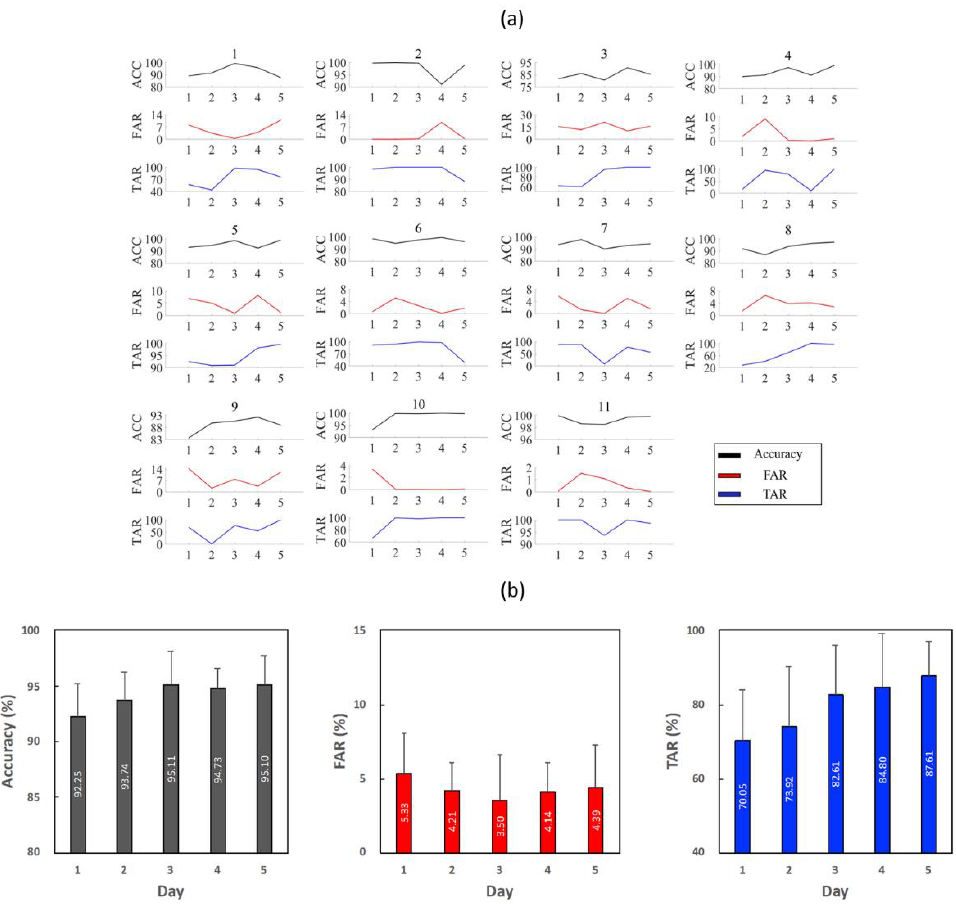
Figure 12. The accuracy, FAR and TAR of 11 subjects over five days of incremental learning ( a ) and the average ( b ) tested using the data recorded a day after the latest training.